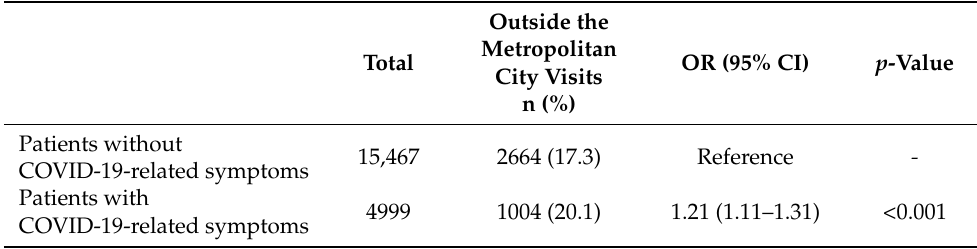
Table 2. Comparison of the number of patient visits from outside the metropolitan city between the experimental and control